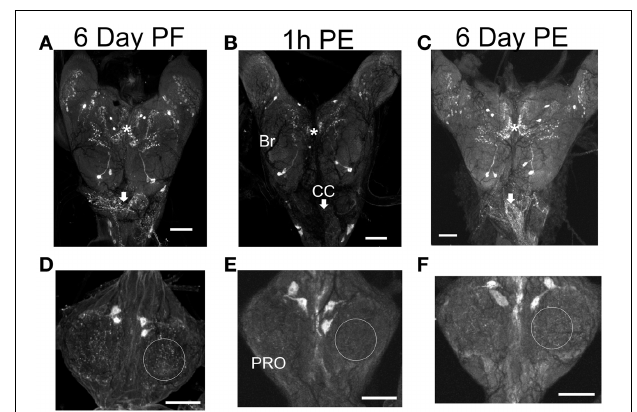
FIGURE 3 | CCAP-like immunoreactive staining in CNS. Central nervous systems were dissected on Day 6 post-fed (PF) (A,D) , 1h post-ecdysis (PE) (B,E) and Day 6 PE (C,F). Reduction in staining intensity was observed in the neuropile and cell bodies in the brain (BR) (compare regions indicated by asterisks), processes in the corpus cardiacum (CC; compare regions indicated by arrows) and neuropile region in the prothoracic ganglion (PRO; compare regions indicated by circle) 1h PE (B,E) . Staining intensity increased by Day 6 PE. n = 30/time point. Scale bars: 100 µ m. levels were reduced by 82 . 6 ± 8 . 5% and 80 . 1 ± 1 . 3%,